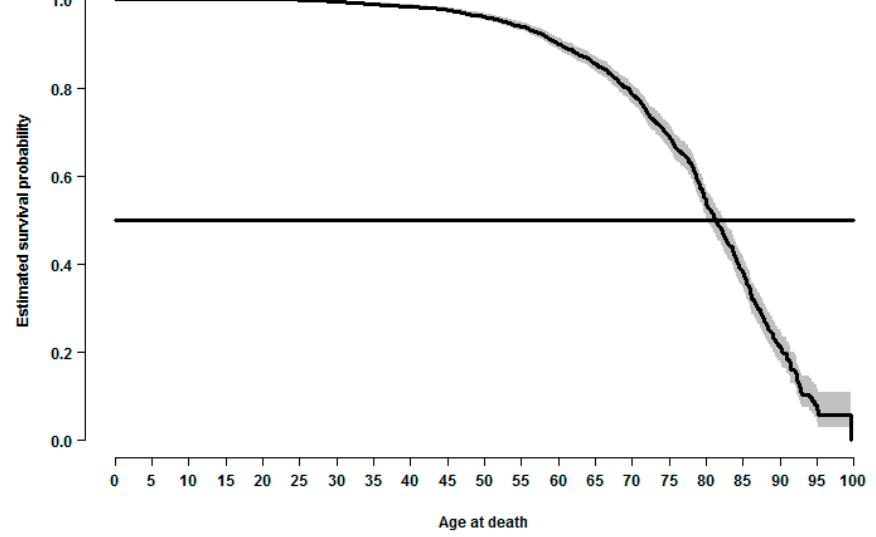
Figure 2. Estimated survival probabilities as a function of age of active and former NBA players. The shaded area represents the 95% confidence bands, and the horizontal line represents survival probability of 0.5.